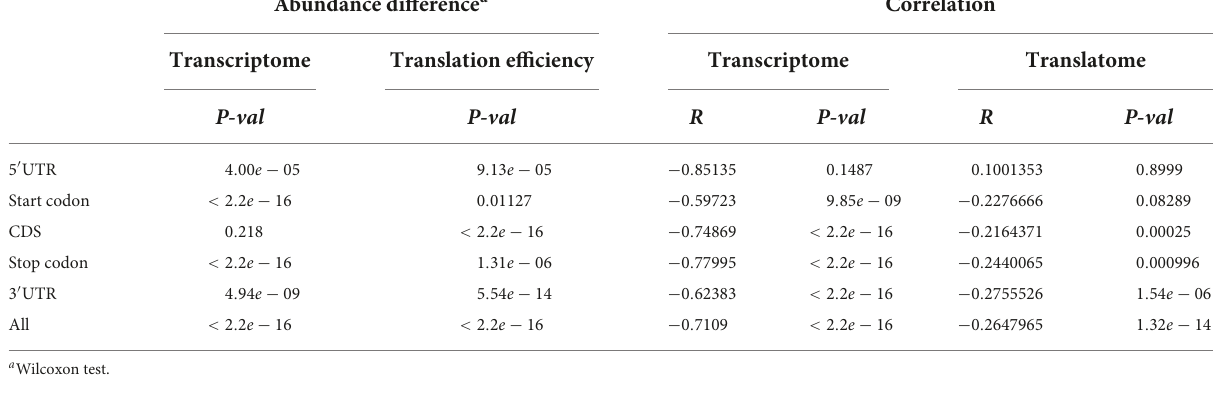
TABLE 2 Transcriptomic and translatomic comparison between different groups of m6A-containing genes and non-methylated genes.